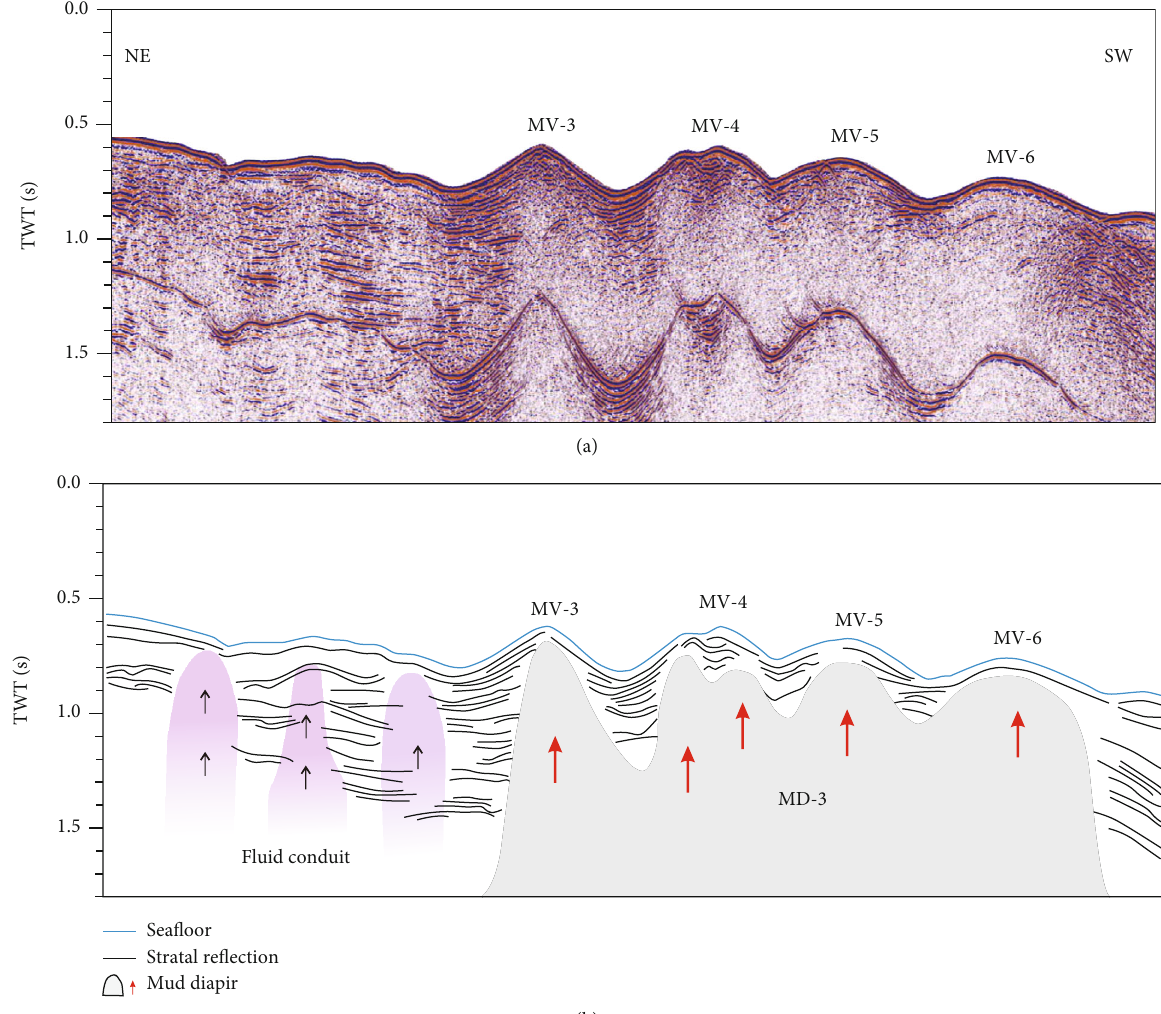
Figure 8: (a) Seismic pro fi le and (b) the interpreted seismic pro fi le of Southwest Taiwan Basin. Four mud volcanoes have developed on the mud diapir, and the surrounding rock is uplifted, mildly. Some fl uid conduits can be noted on the pro fi le (modi fi ed from